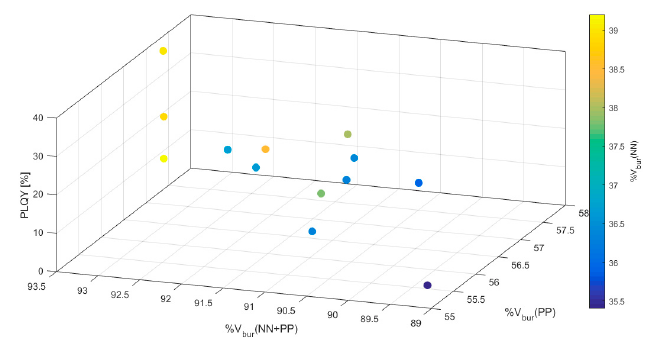
/ b – 7a / b [26]. bur (NN) for compounds 2a